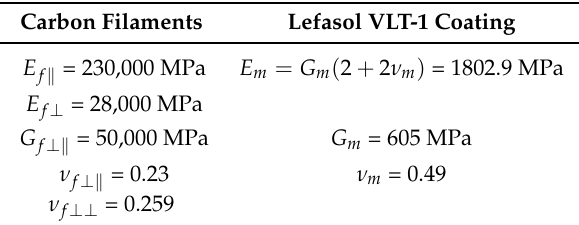
Table 1. Elastic parameters of yarn